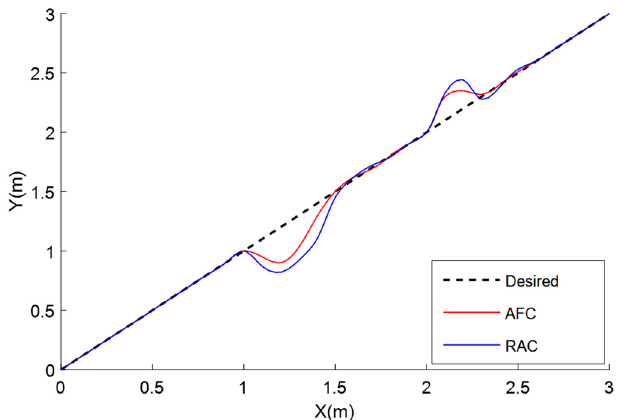
Figure 9. Apply disturbances as an obstacle in the path of the robot.